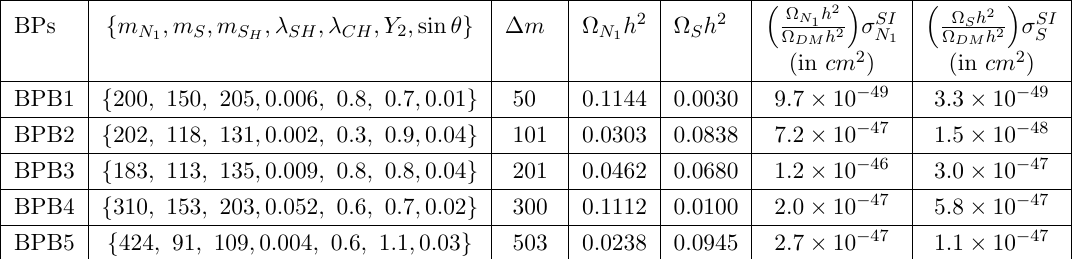
(cid:1) m plane 1 (cid:0)